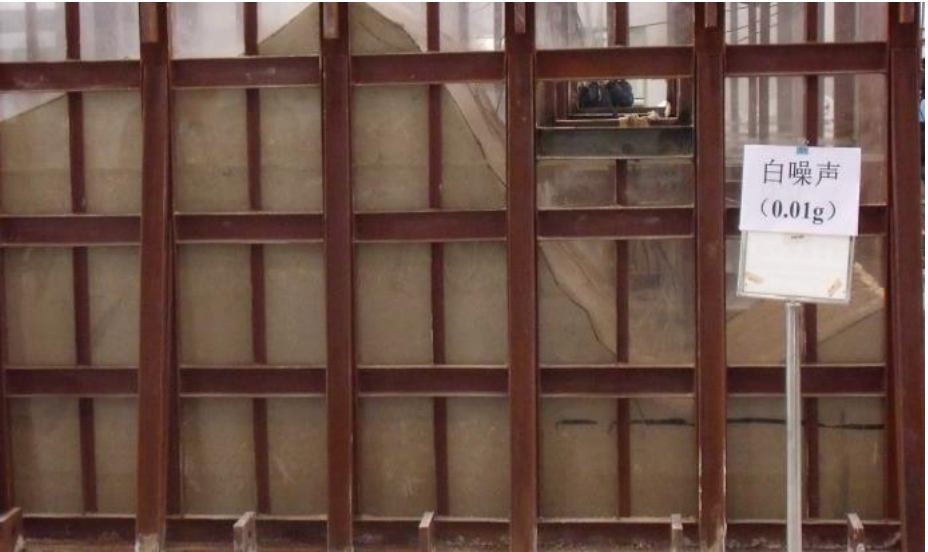
Figure 5. Shaking table test model of one-sided rock slope.